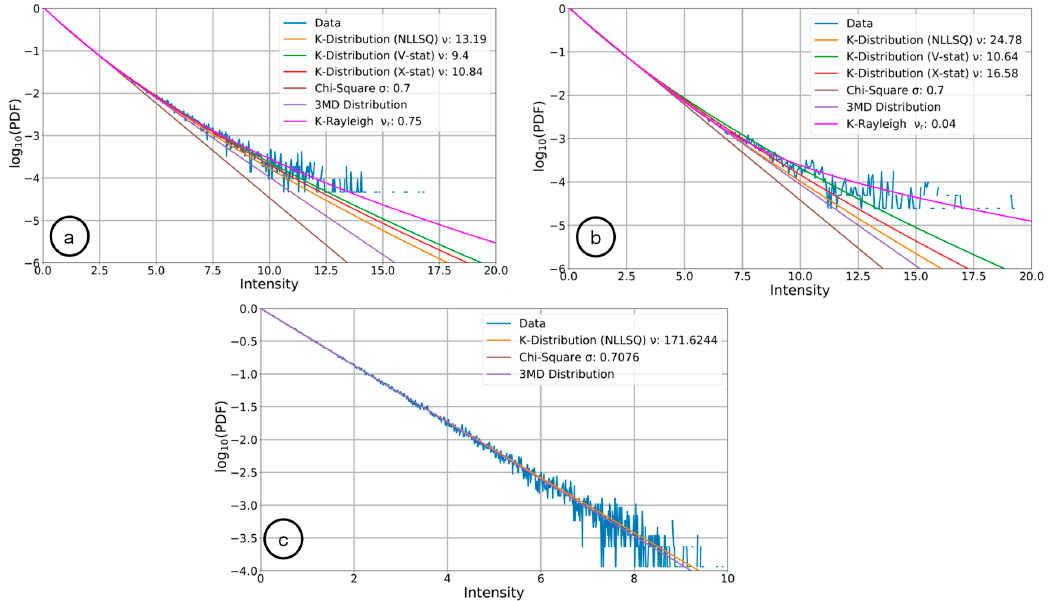
Figure 24. Logarithmic PDFs of different distribution functions plotted for ( a ) near ( b ) mid and ( c ) far range using the data acquired during the linear flight track (cf. Figure 23b). The estimated parameters corresponding to different distribution functions are shown in the legends of the plots, apart from the 3MD model since it has 8 unknowns.